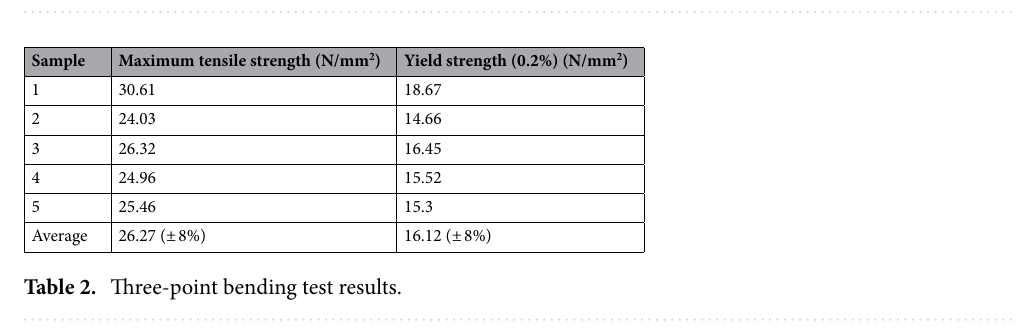
Figure 5. Rectangular beam shaped specimens for three-point bending test ( a ). Stress–strain curve of the sample 1 ( b ).